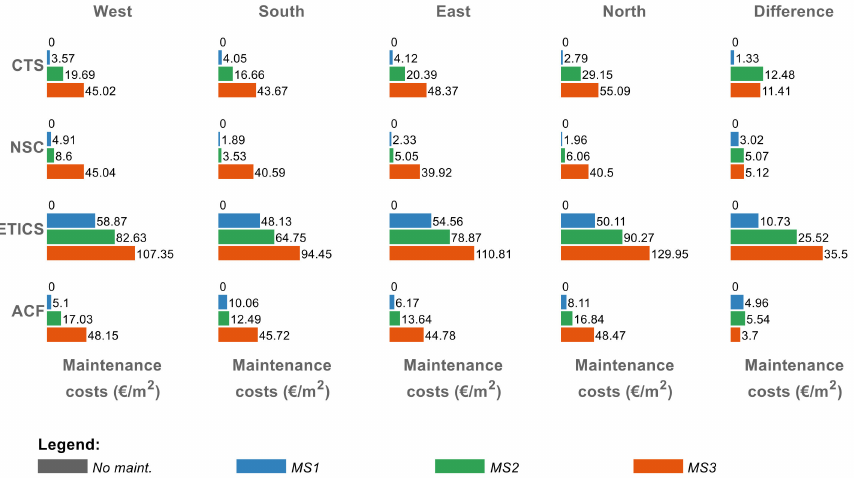
Figure 14. Comparison of the maintenance costs according to orientation for a time horizon of 80 years.